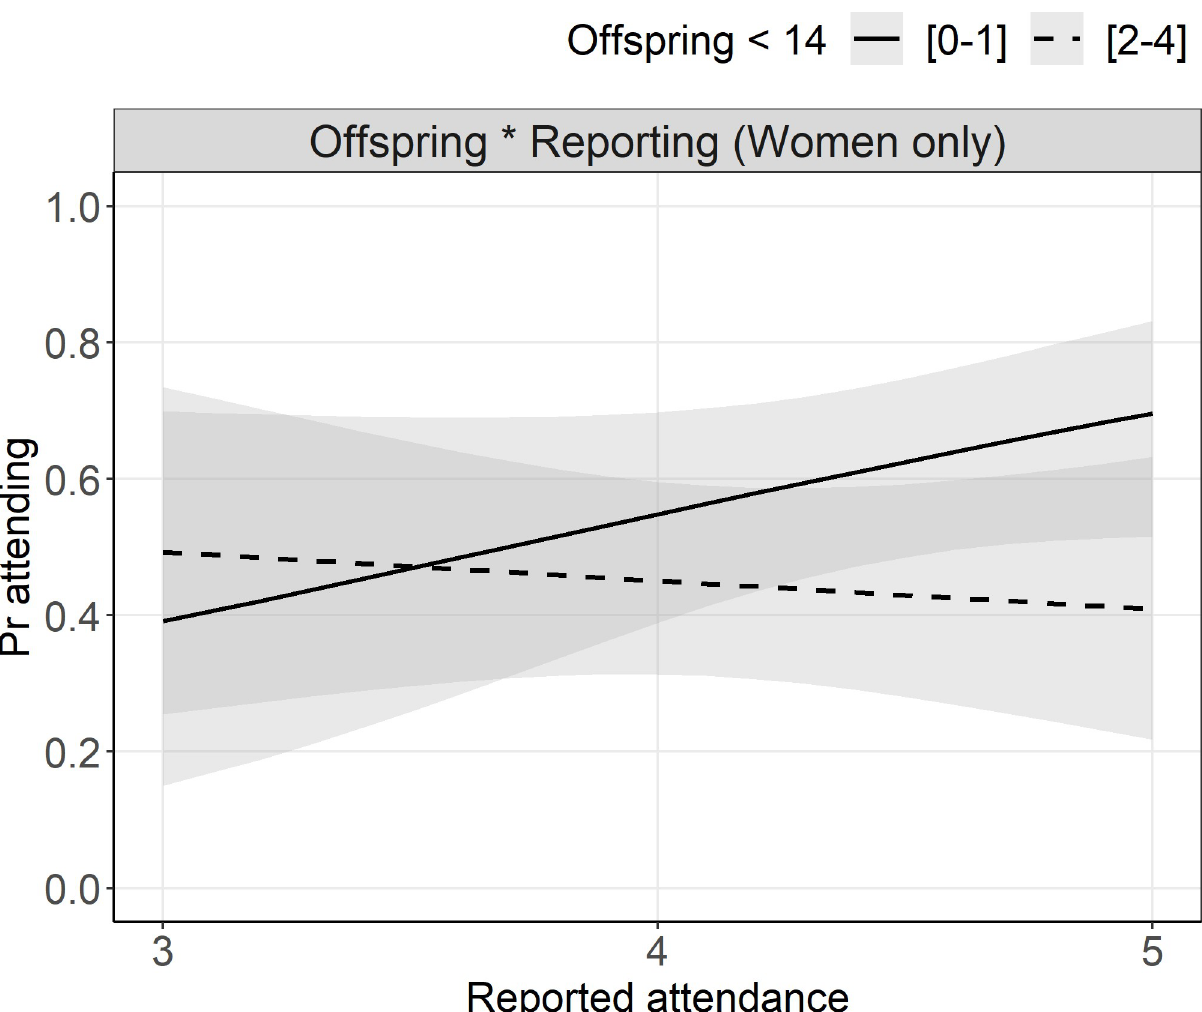
Fig 2. Observed attendance by reported attendance among women with different numbers of offspring. Regression lines with 95% CIs. Self- reported attendance was positively associated with observed attendance for women with zero to one child (n = 13), but this relationship was reversed for women with two or more children (n = 9). Note that this plot is a simplified illustration of the statistical model where the number of children was treated as a continuous variable.